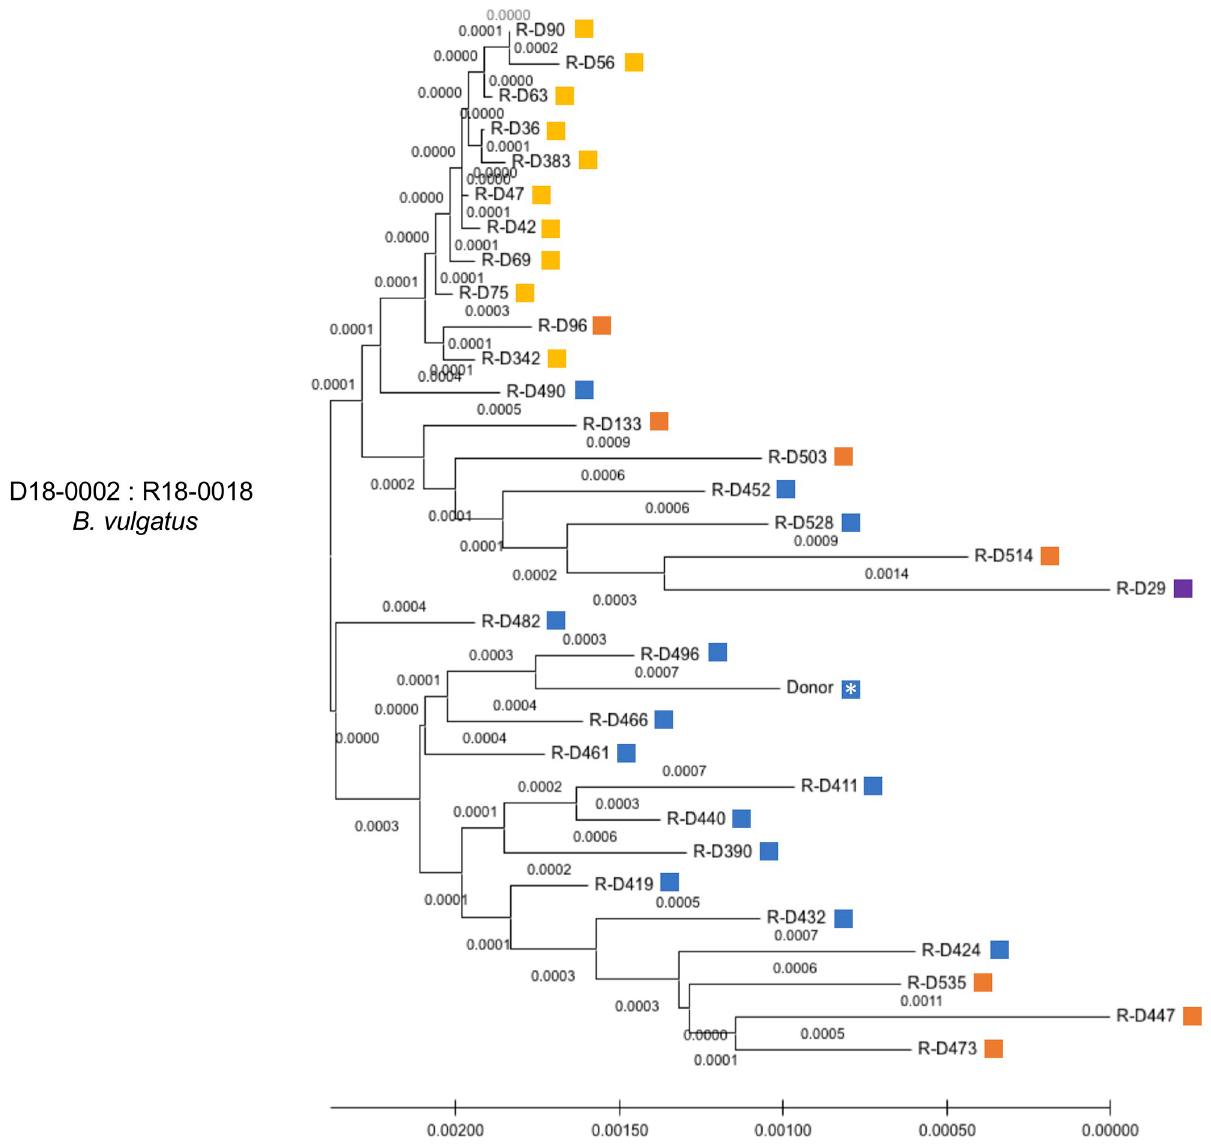
Fig 7. StrainPhlAn analysis for B . vulgatus FMT donor 18–0002 and recipient 18–0018 pair. StrainPhlAn analysis on donor 18–0002 and recipient 18–0018 pair was done for Bacteroides vulgatus across all samples in this pair. A neighbor-joining (NJ) tree was constructed and the tree is drawn to scale with branch lengths. The same steps described in the legend of Fig 3 were then applied to complete the tree using MEGA X. The blue and purple boxes shown next to the NJ tree match the color boxes shown in Fig 5A, the yellow boxes depict a new strain and orange boxes indicate a recombinant strain both shown as numerical numbers in Fig 5A. The yellow boxes showed consistent WSS scores related to donor or recipient and the orange boxes showed either similar WSS scores observed between donor and recipient or a higher score found in the recipient than donor. A white asterisk indicates a donor pre FMT